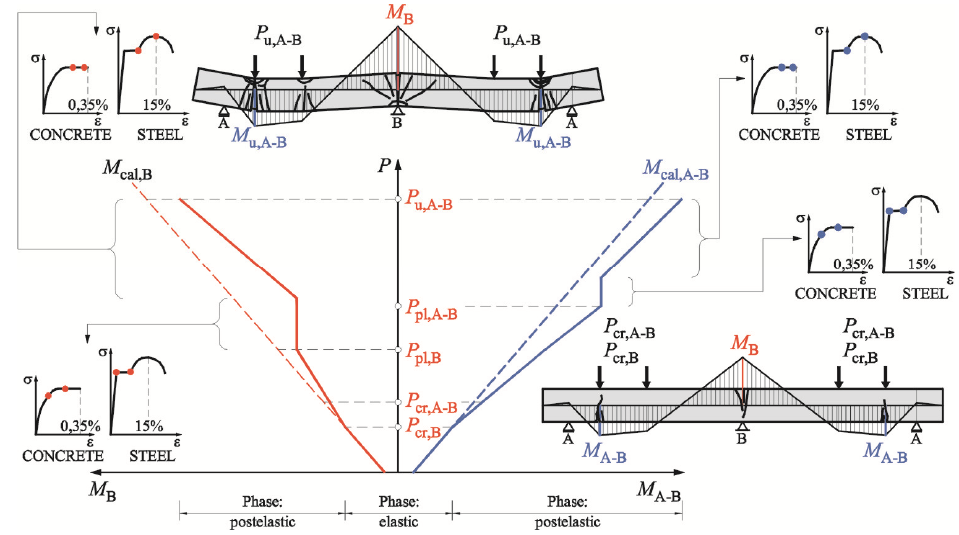
actuator, 3—the ARAMIS system, 4—hydraulic power pack.